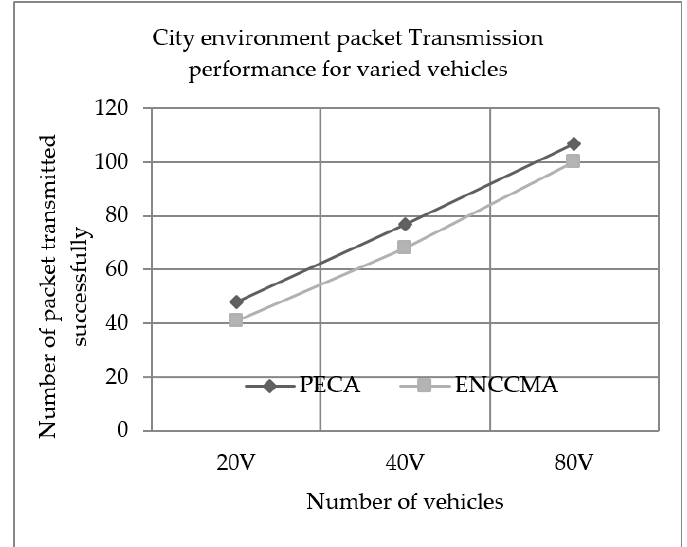
Figure 4. City environment packet Transmission performance for varied vehicles.